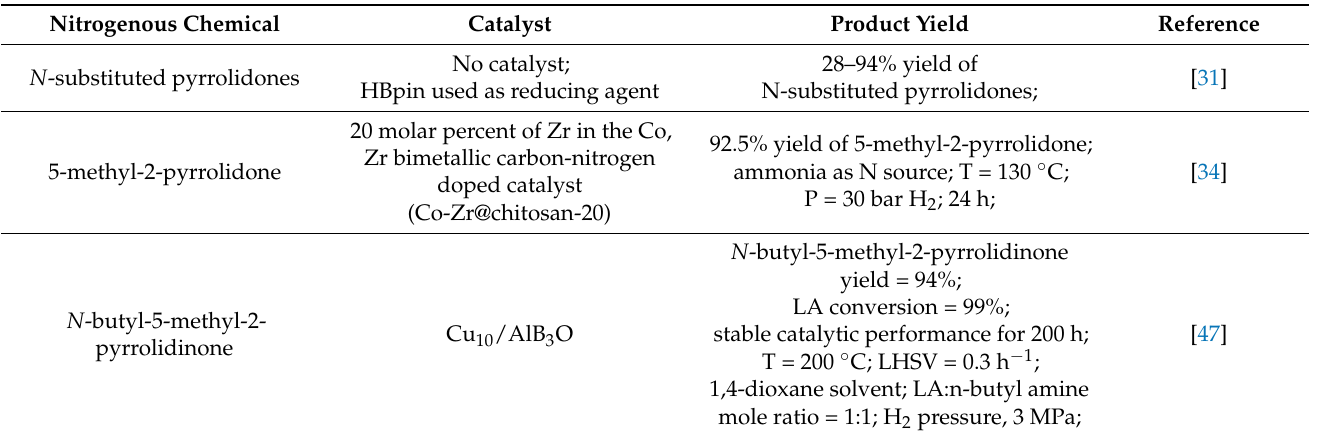
Table 3. Production of biobased nitrogenous